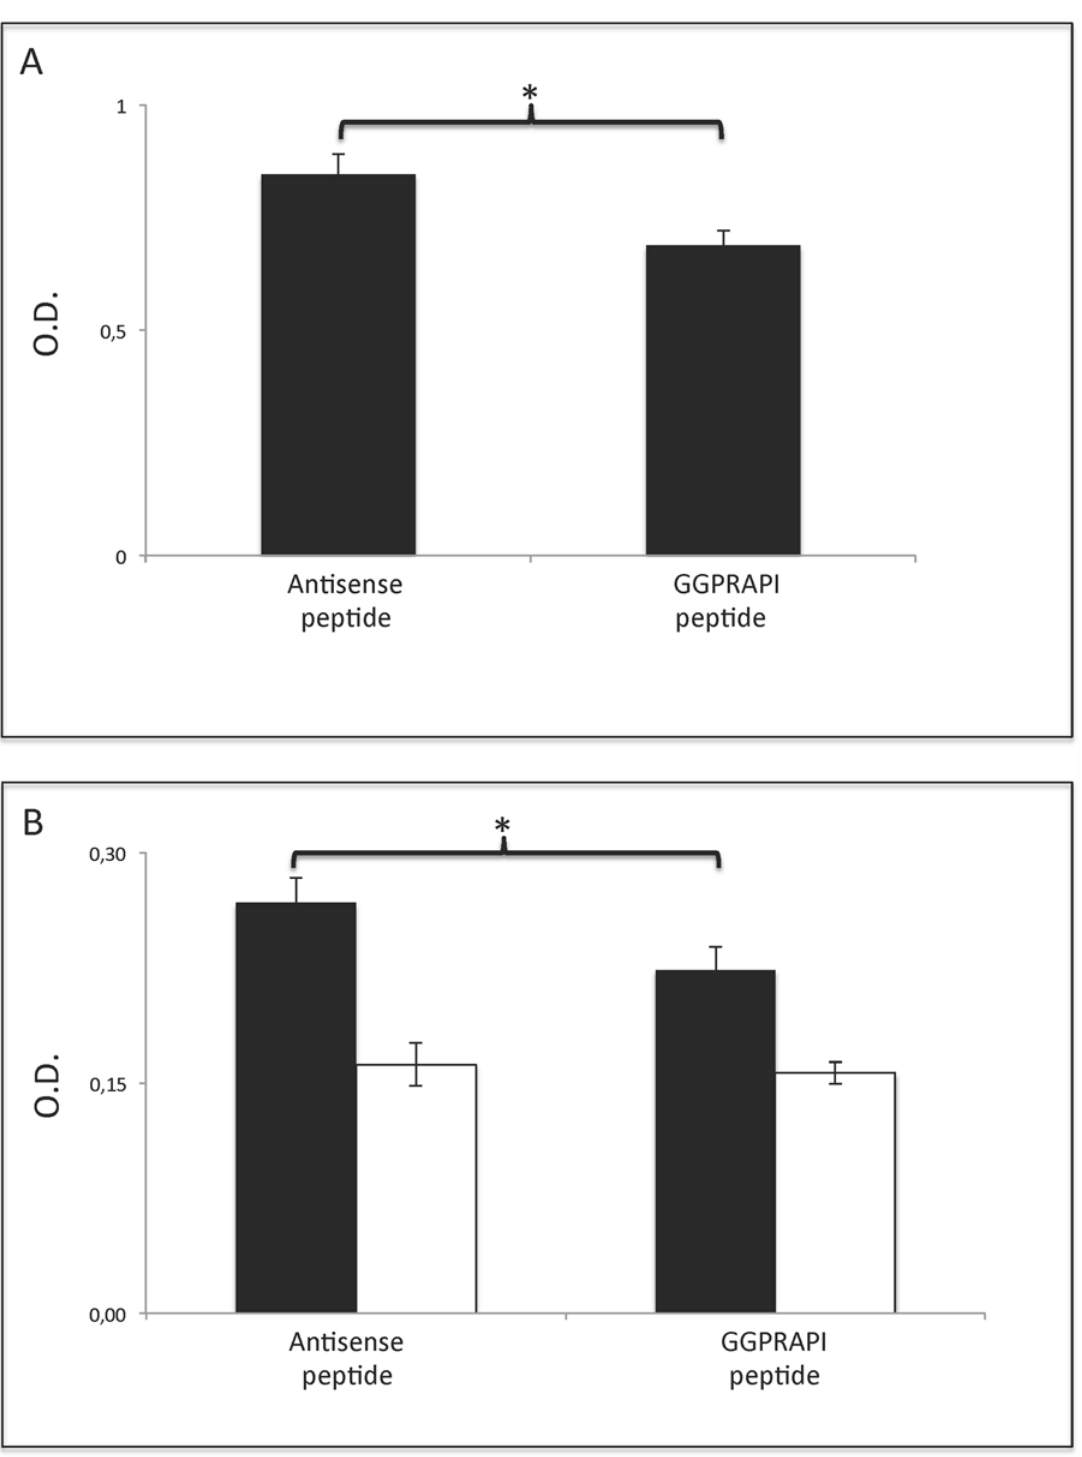
Fig 4. Ubiquitin is specifically recognized by the immunized rabbit antiserum and the index patient serum as determined by binding inhibition. A) Addition of 600 μ g GPGRAPI peptide (p < 0,01), but not a control peptide significantly decreases binding of the immunized serum to Ubiquitin. B) Similarly, serum from the index patient (black columns) was competitively inhibited. A human control serum (white columns) bound lower than the index patient serum and was not inhibited by GPGRAPI peptide. Error bars represent standard deviation of triplicates, * indicates p < 0.01.